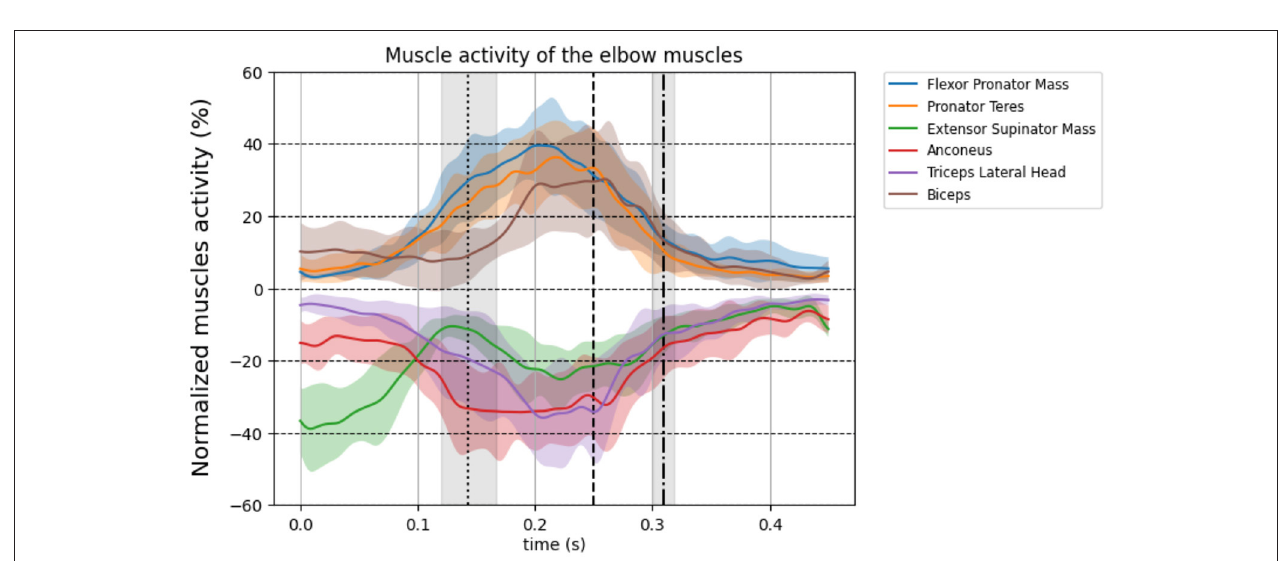
FIGURE 2 | Group level normalized EMG signal time-series for the upper arm muscles corrected for EMD (50ms). The thick line shows the mean over all 11 participants and standard deviation is shown as transparent area around the mean. The flexors are plotted positively on the vertical axis and the extensors are plotted negatively on the vertical axis. Brown line: biceps brachii, blue line: Flexor pronator mass, orange line: pronator teres, green line: extensor supinator mass, purple line: triceps brachii, red line: anconeus. The three vertical lines represent FC (dotted), MER (dashed), and BR (dot dashed), respectively. Be aware: the normalized activity ranges from 0% till 100%, here the y-axis scale ranges from 0% to 60% for better